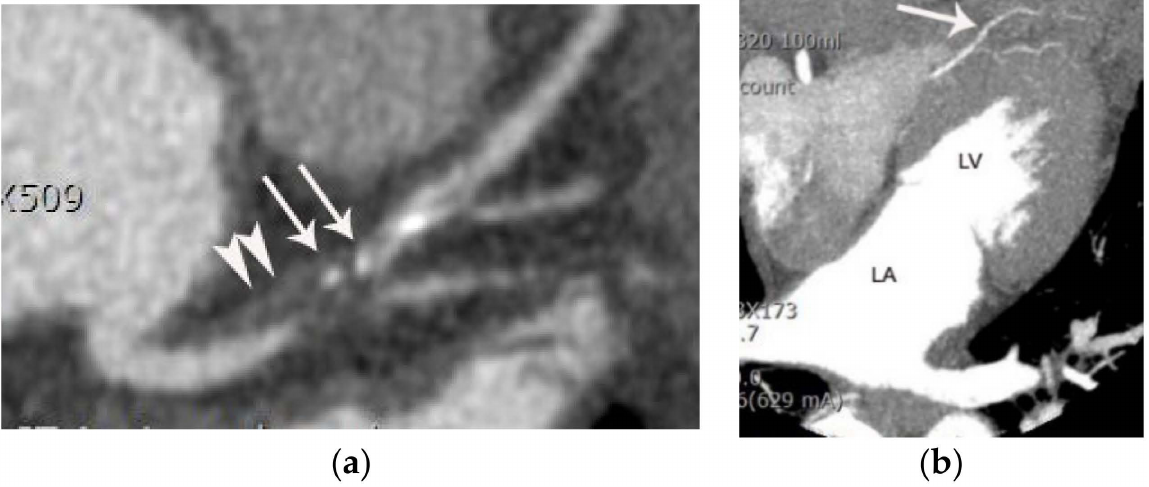
Figure 5. A case of unstable angina in a 61-year-old male patient with crescendo angina. ( a ) Curved multiplanar reformatted image shows near-total occlusion in the distal left main coronary artery. Note the napkin ring sign (arrowheads), positive remodeling, and spotty calcifications (arrows). However, there is no myocardial hypoattenuation in the left ventricle on a four-chamber image. Note a collateral artery (arrow in ( b )) from the posterior descending coronary artery coursing to the distal left anterior descending coronary artery. LV and LA indicate left ventricle and atrium,